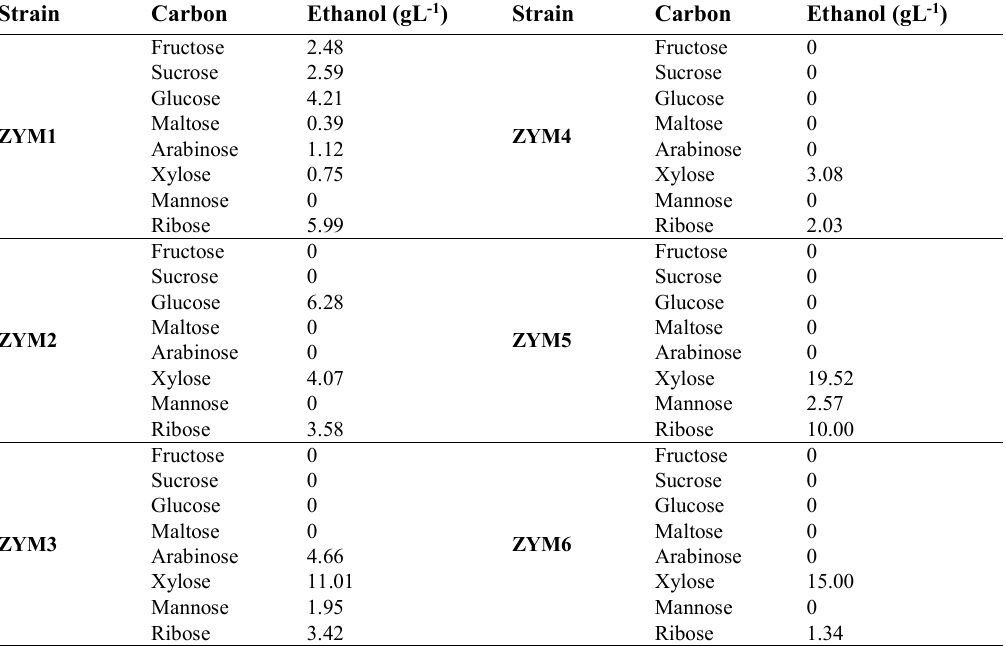
Table 3. Effect of different carbon sources on ethanol production by isolates.